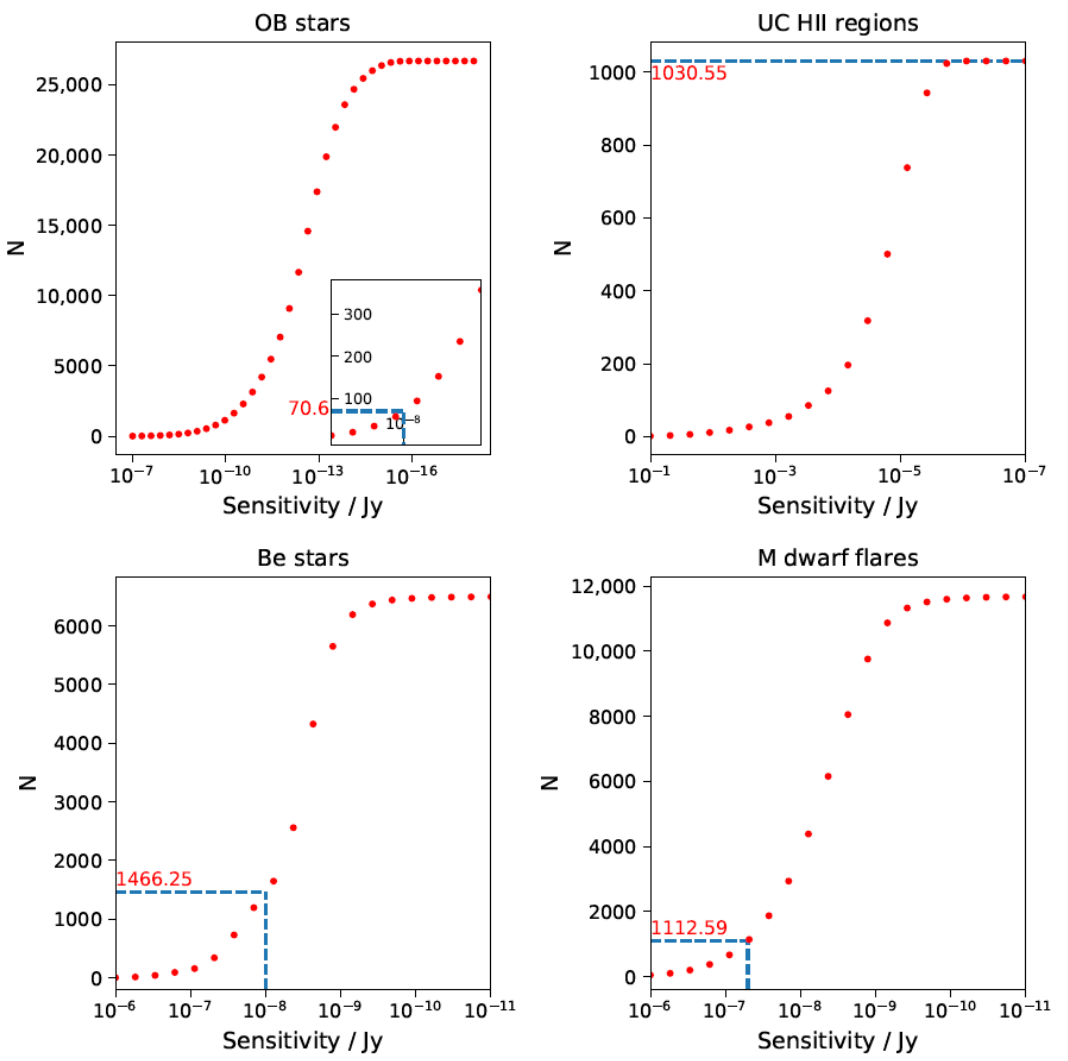
Figure 12. Numbers of detectable sources per square degree toward the galactic center as a function of the detection thresholds. The blue dashed lines are the limit assumed in this work; the corresponding numbers of sources are given above it.